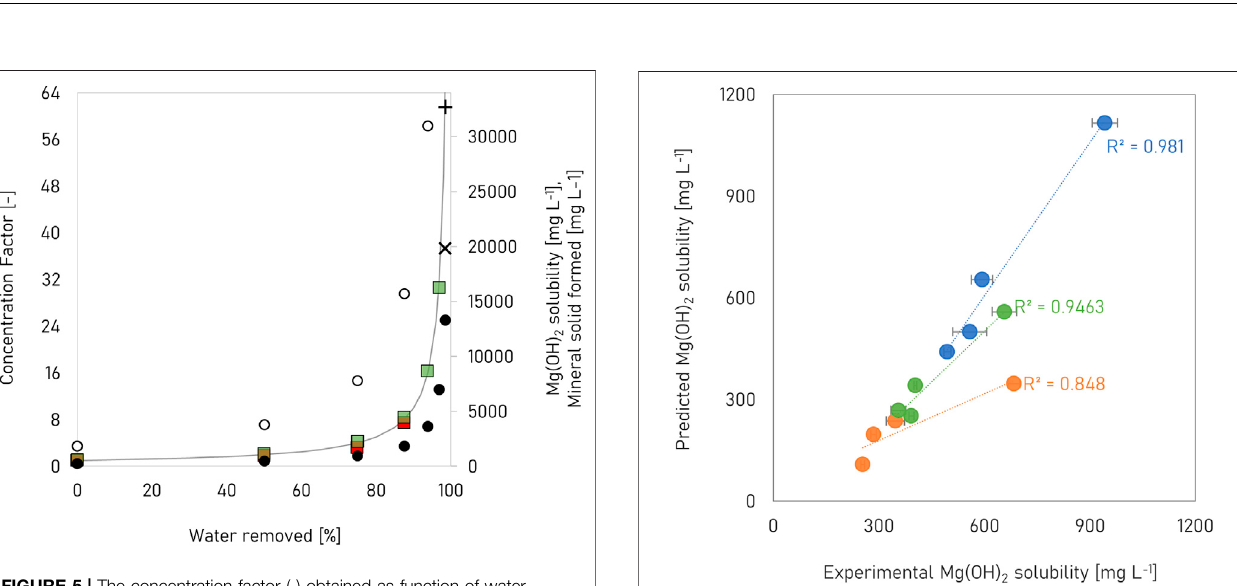
FIGURE 4 | The simulated (A) solubility of Mg(OH) 2 and (B) pH of fresh human urine at different concentration factors and temperatures.